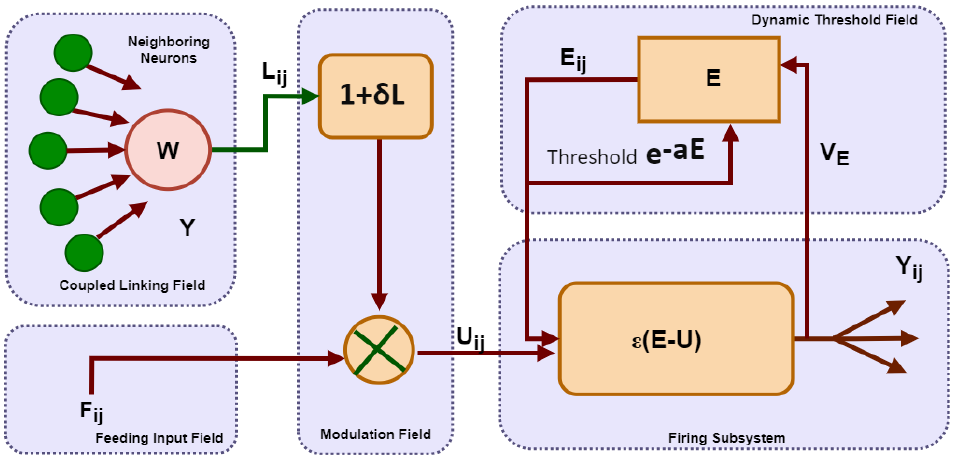
Figure 4. Schematic Structure of PCNN